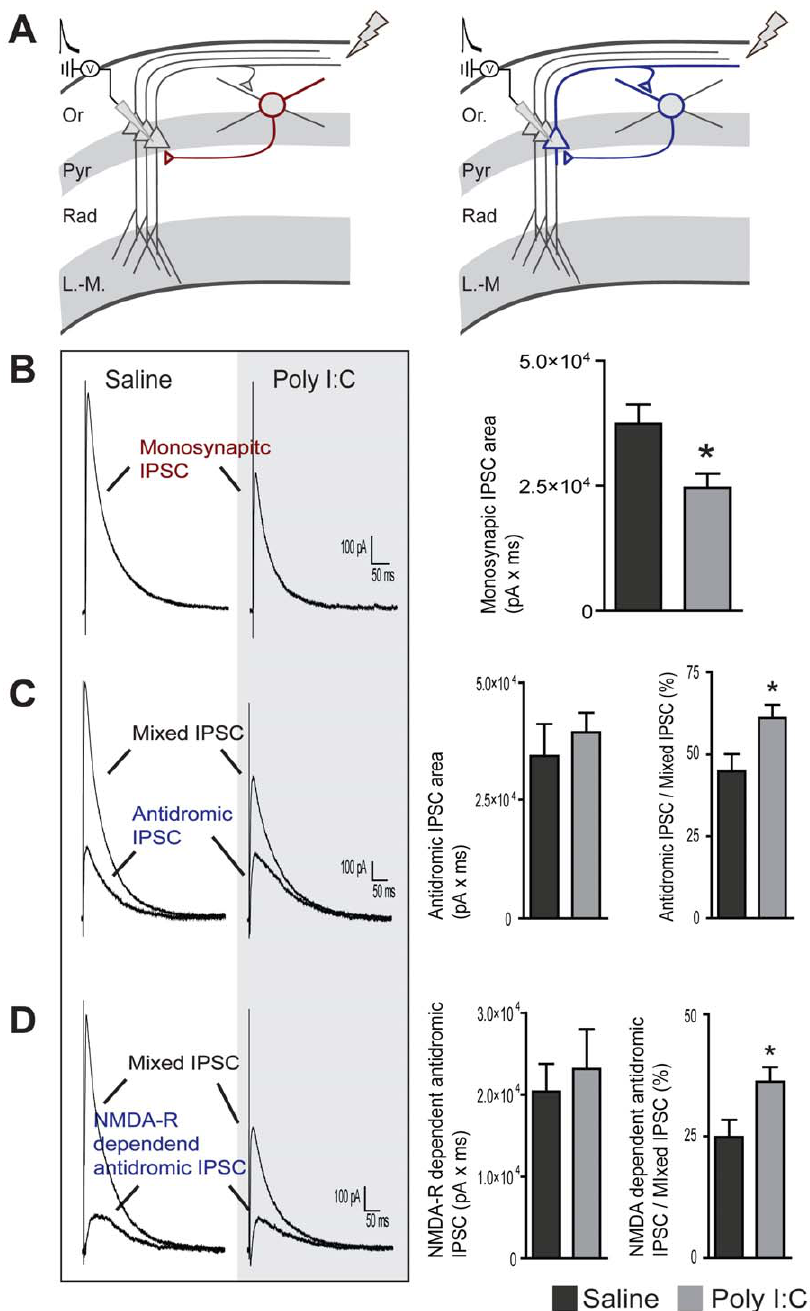
Figure 3. Prenatal immune challenge reduced monosynaptic IPSCs but increased recruitment of local inhibitory feedback interneurons. A ) Recording configuration and diagram showing the two components of the mixed IPSC (composed of the monosynaptic IPSC from direct activation of local interneurons shown in red and the antidromic IPSC from feedback interneurons activated by CA1 recurrent projections shown in blue). B ) monosynaptic IPSCs isolated by the addition of DNQX (20 m M) and AP-5 (25 m M). Left: representative recordings from both groups. Right: average monosynaptic IPSC area for both groups (n=8 for each group). C ) Isolation of the antidromic IPSC. Left: representative recording showing the mixed IPSC before the addition of DNQX (20 m M) and AP-5 (25 m M) and the isolated antidromic IPSC (IPSC sensitive to AP-5 and DNQX). Middle: average magnitude of the antidromic IPSC area from both groups. Right: fraction (in percent) of the mixed IPSC contributed by the antidromic IPSC (n=8 for each group). D ) Isolation of the NMDA receptor-dependent antidromic IPSC. Left: representative recording showing the mixed IPSC before the addition of AP-5 (25 m M) and the NMDA receptor-dependent antidromic IPSC. Middle: average magnitude of the NMDA receptor-dependent antidromic IPSC area from both groups. Right: fraction (in percent) of the mixed IPSC contributed by the NMDA receptor- dependent antidromic IPSC (n=8 for saline and n=7 for the poly I:C treated group). Stimulation intensity was 300 m A and each trace displayed corresponds to the average of 5 consecutive responses.